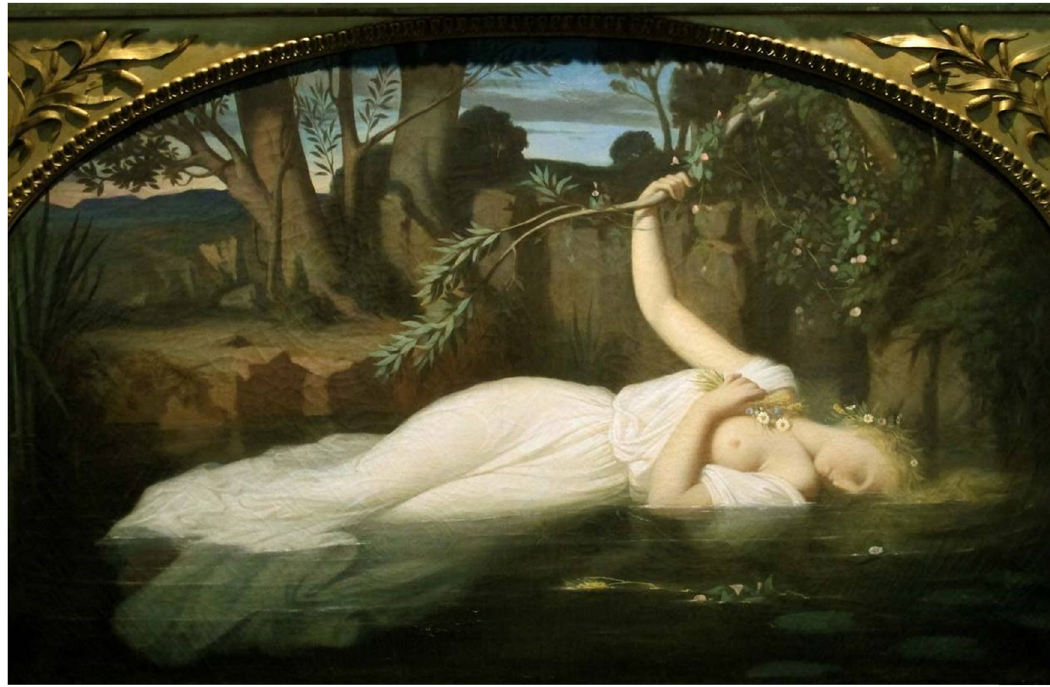
Figure 1: Leopold Burthe, “ Ophélie, ” 1851, oil on canvas. https://scribe4haxan.tumblr.com/post/110217571266/ophelie - de - leopold -